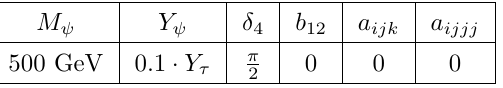
Table 2. Additional scalar and Yukawa coupling parameters that are the same across all bench- mark points.